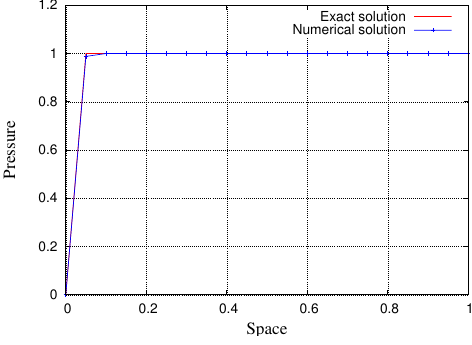
Figure 8. Comparison between an accurate enough approximation of the analytical solution and an approximated solution for pressure obtained by perturbed scheme (3.6) for the column problem at time T = 0 . 001 and N = M = 20.